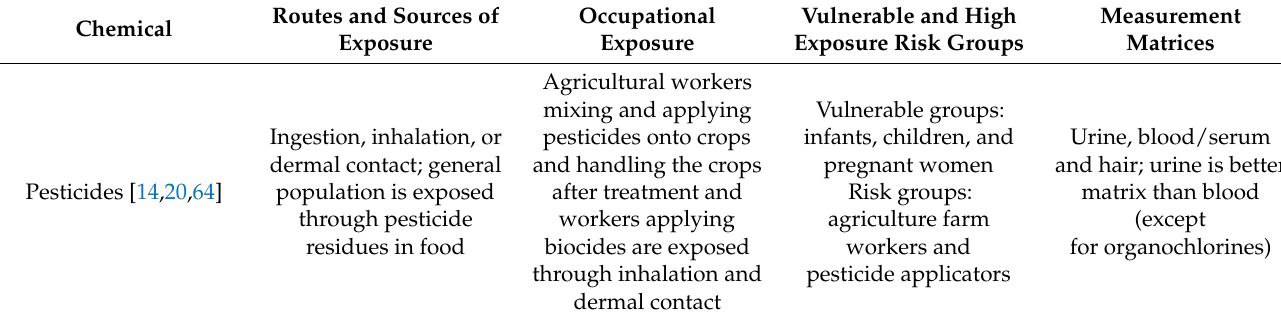
Table 1. Common features of the